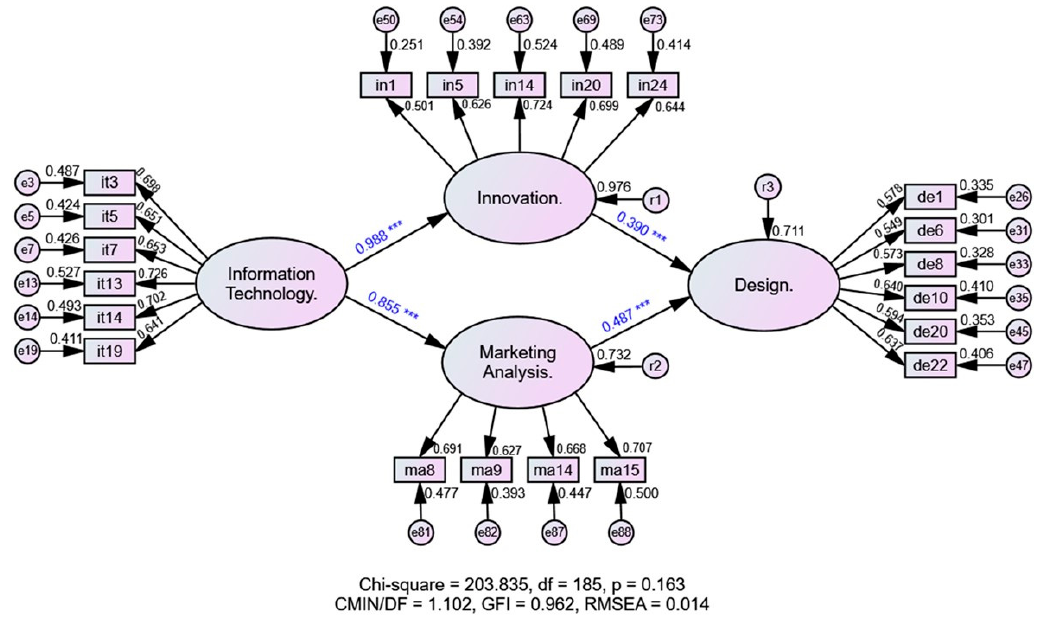
Figure 2. The final simplified and refined structural equation model with standardized path coe ffi cients Figure 2. The fi nal simpli fi ed and re fi ned structural equation model with standardized path and factor coef fi cients and factor loadings.